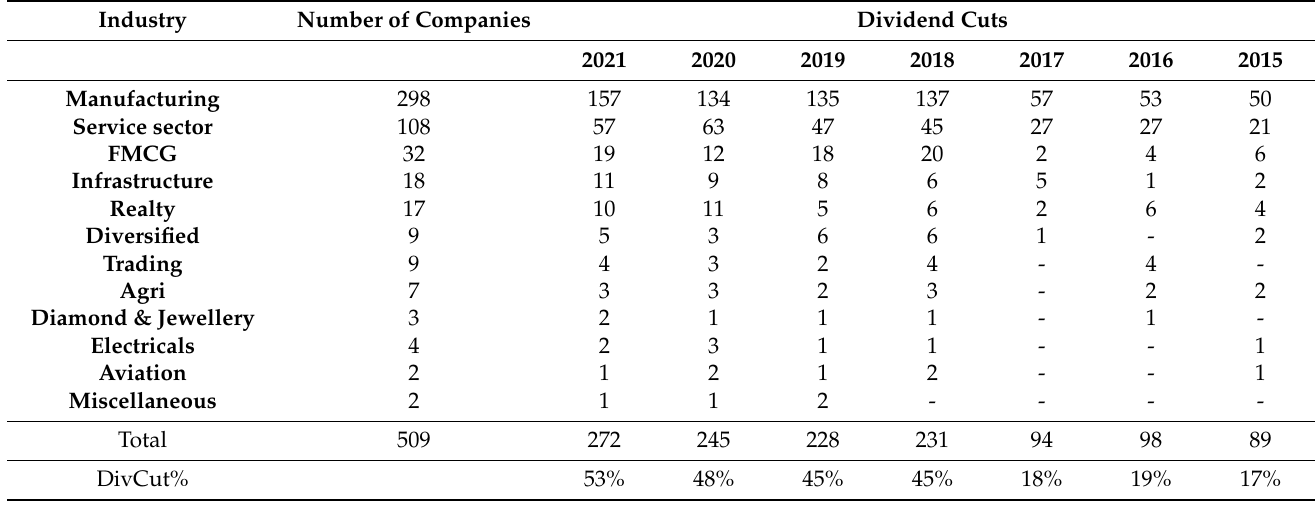
Table 5. Dividend cut trends (2015) onwards across sectors.